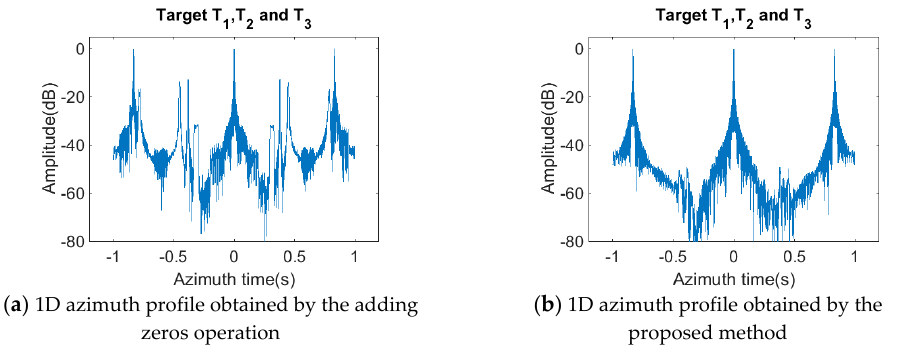
Figure 14. 1D Azimuth profiles of T 1 , T 2 , and T 3 : ( a ) 1D azimuth profile obtained by the adding zeros operation; and ( b ) 1D azimuth profile obtained by the proposed method.